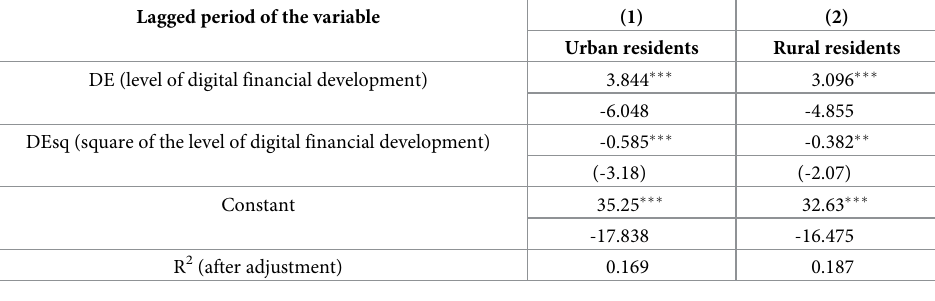
Table 5. Urban-rural heterogeneity in digital finance and income distribution.